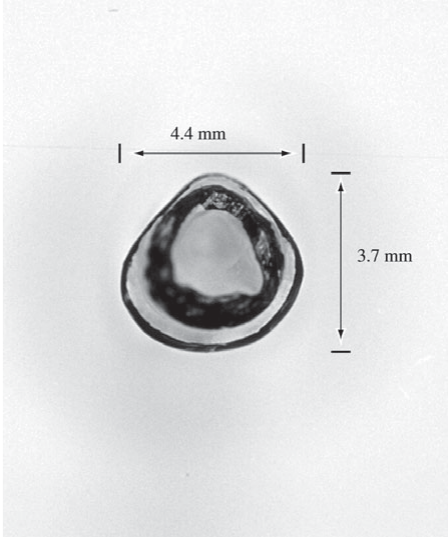
Figure 2 . Top view of the analogous.